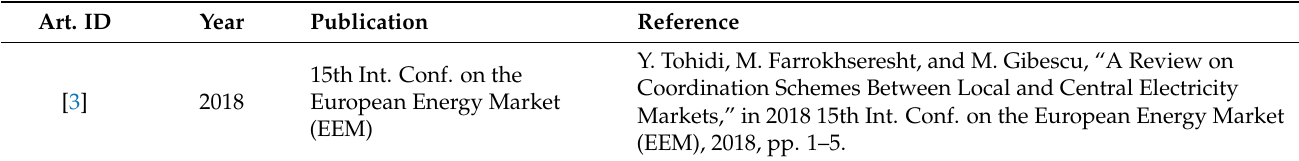
Table A1. Articles included in the